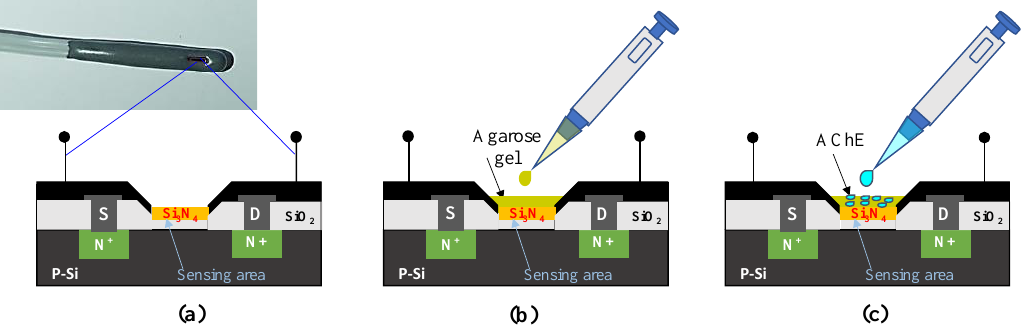
Figure 1. Schematic of the ISFET surface preparation: ( a ) ISFET sensing area, ( b ) application of agarose gel, and ( c ) enzyme immobilization.